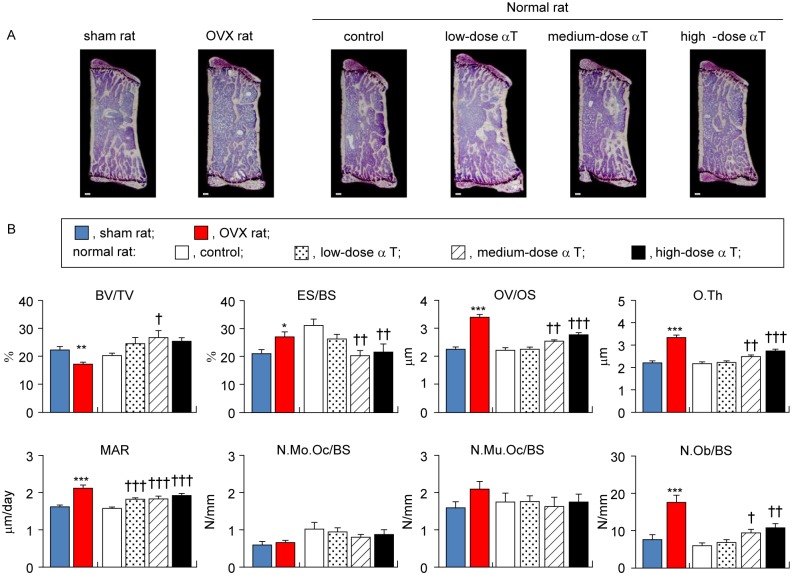
Histomorphometric analysis of secondary cancellous bones in vertebral body.(A) Representative micrographs of sagittal sections of vertebral bodies stained with Villanueva bone staining without decalcifying treatment are shown. (B) Histomorphometrical parameters (BV/TV, bone volume/tissue volume; ES/BS, eroded surface/bone surface; OV/OS, osteoid volume/osteoid surface; O.Th, osteoid thickness; MAR, mineral apposition rate; N.Mo.Oc/BS, number of mononuclear osteoclast/bone surface; N.Mu.Oc/BS, number of multinuclear osteoclast/bone surface; and N.Ob/BS, number of osteoblast/bone surface) of secondary spongiosa in vertebral bodies are shown. Data are presented as mean ± standard error of the mean. *P < 0.05, **P < 0.01, and ***P < 0.001 vs. sham rat group; †P < 0.05, ††P < 0.01, and †††P < 0.001 vs. normal rat control group.